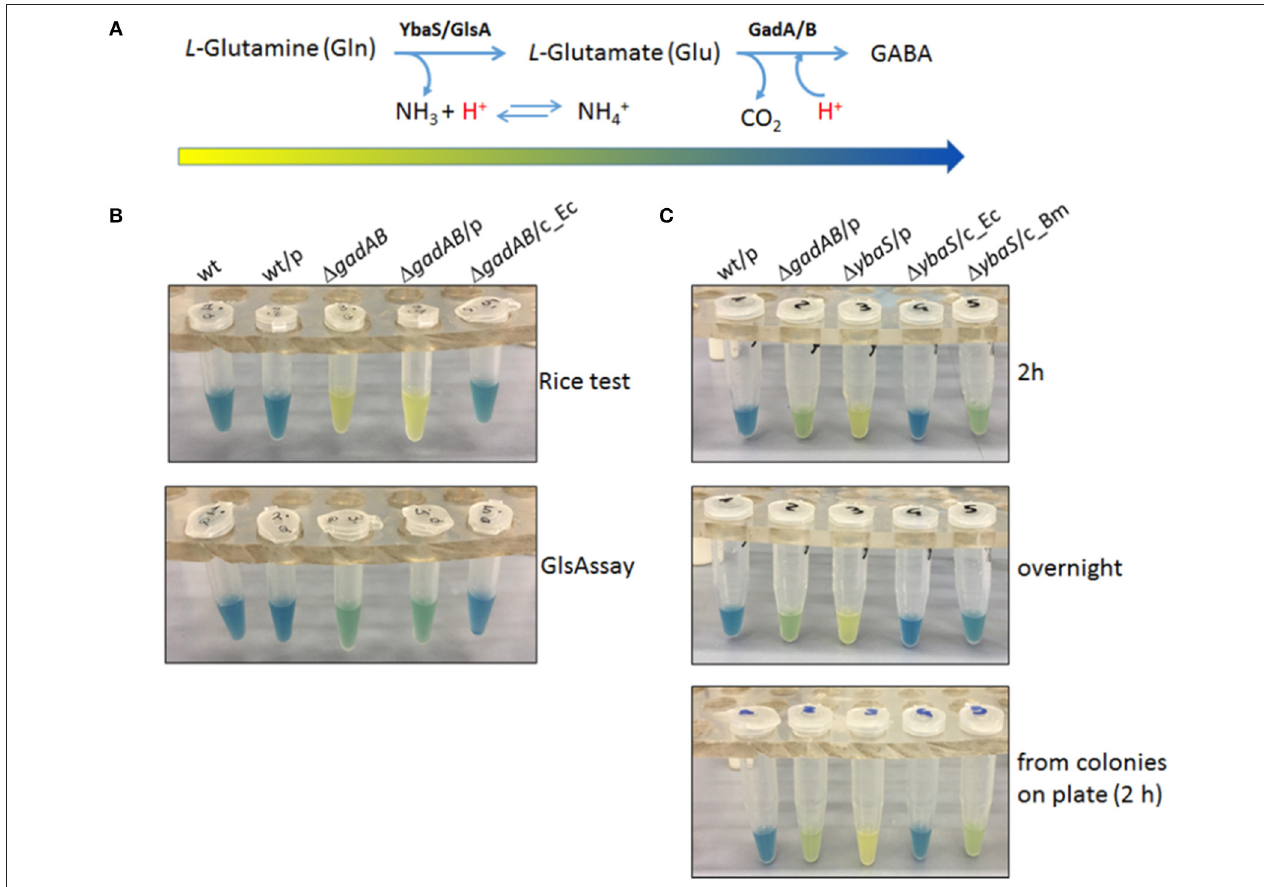
FIGURE 2 | The GlsAssay in Escherichia coli K12 MG1655. (A) Working hypothesis of the GlsAssay based on the substrates and the enzymes involved. The arrow that begins yellow and ends blue corresponds to the approximate change in color that is expected to occur as the GlsAssay develops, using Gln as starting molecule. (B) Preliminary controls. Comparison between the Rice test performed using glutamic acid (upper panel) and the GlsAssay performed using glutamine (lower panel). The strains used were: E. coli wild type (wt); wt/pBBR (wt/p); 1 gadA - 1 gadB ( 1 gadAB ); 1 gadA - 1 gad/ pBBR ( 1 gadAB /p); 1 gadA - 1 gad/ pBBR_ gadBC ( 1 gadAB /c_Ec). The presence of the empty plasmid pBBR1MCS (p) had no effect on the outcome of both tests. The strains were grown for 24h in LBG pH 5.0, typically used for AR2 assay and Rice test in E. coli ( Occhialini et al., 2012; Damiano et al., 2015). The GlsAssay was carried out at 37 ◦ C overnight. (C) Optimized conditions of GlsAssay as described in Materials and Methods (section Rapid Glutaminase Assay (“GlsAssay”) and in Figure S2 ). The assay was carried out on the strains: wt/pBBR (wt/p); 1 gadA - 1 gadB /pBBR ( 1 gadAB /p); 1 ybaS /pBBR ( 1 ybaS /p); 1 ybaS /pBBR- ybaS_Ec ( 1 ybaS /c_Ec); 1 y baS /pBBR- glsA _ Bm ( 1 ybaS /c_Bm). The incubation time is shown on the right. p, plasmid pBBR1MCS; c, complemented strain with the missing